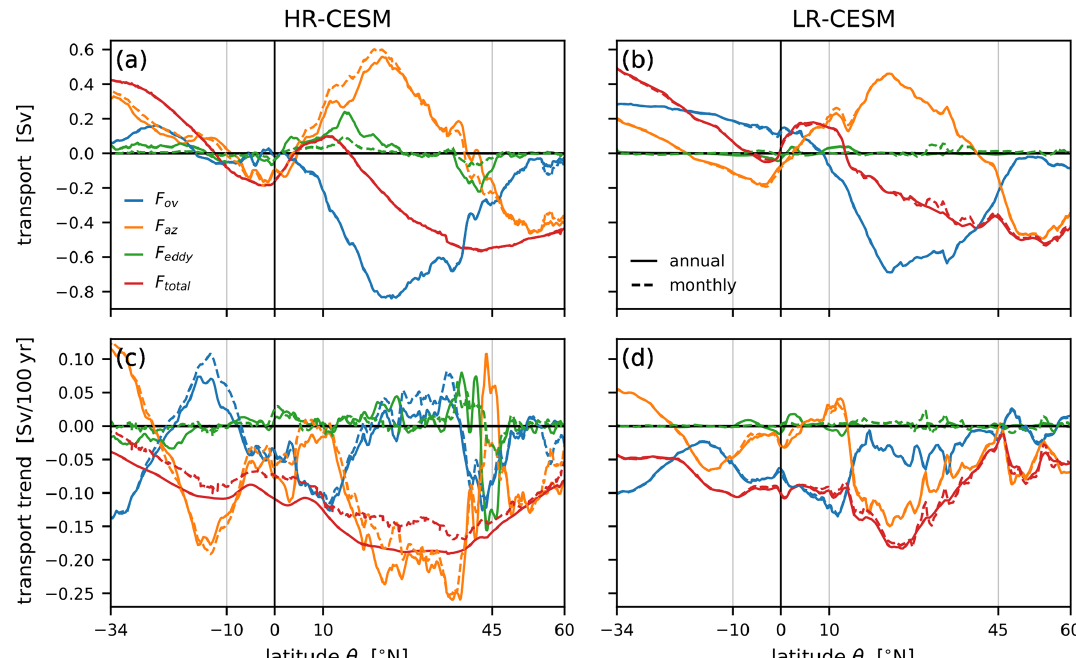
Figure B1. Freshwater transport terms calculated from annually (solid lines; as in Figs. 7, 9, and 10) vs. monthly (dashed) averaged model output. The difference is the effect of seasonality.